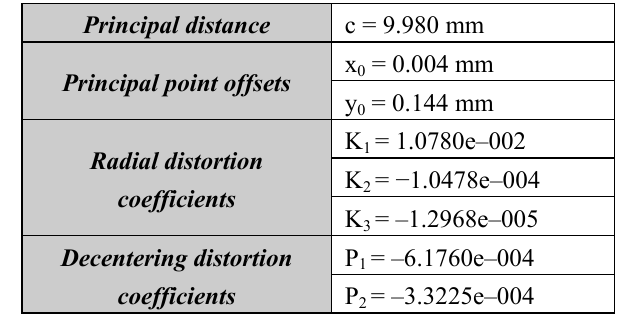
Table 2. Estimated internal parameters of the SR-4000 camera.